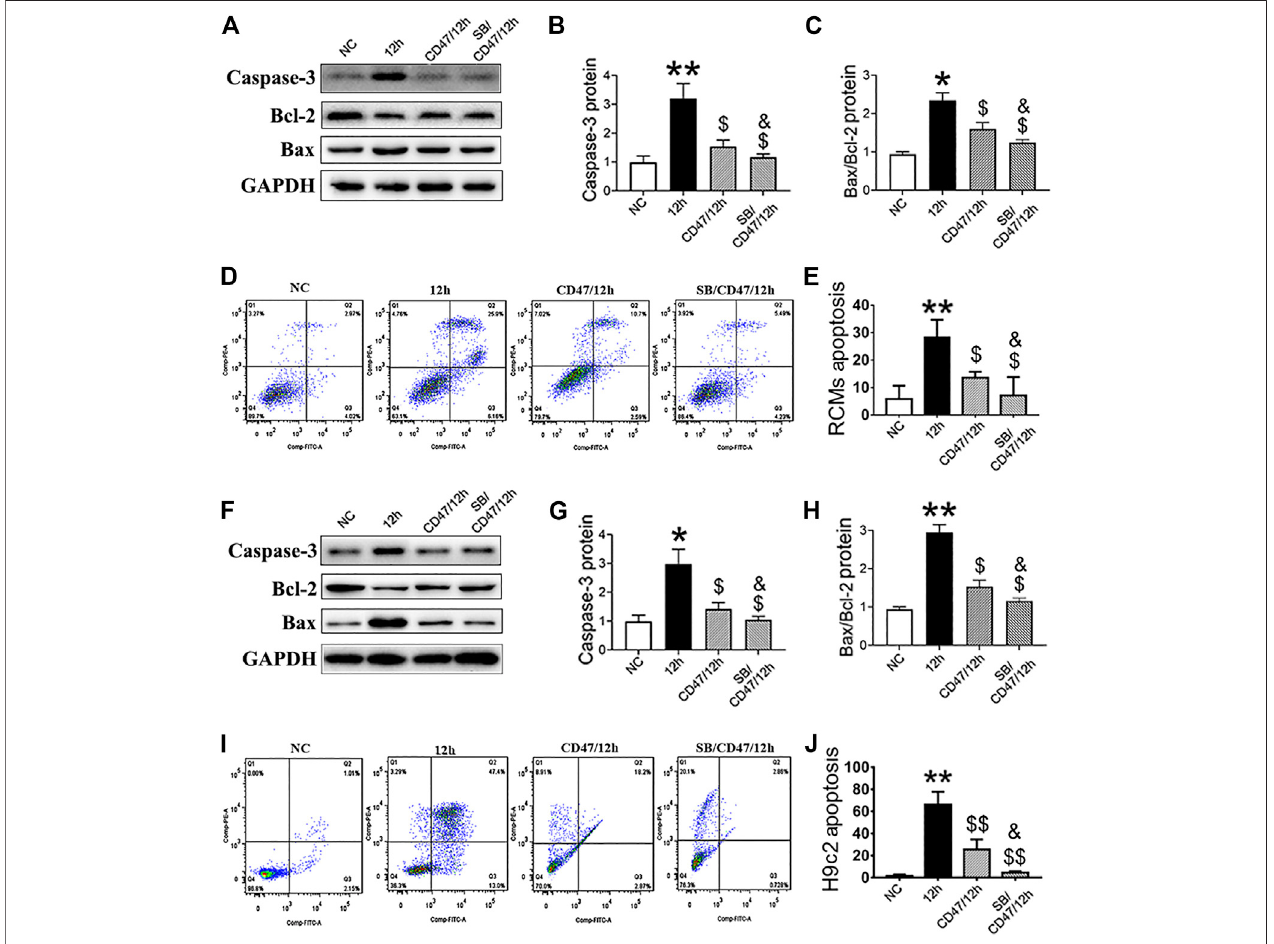
FIGURE 8 | Simultaneous targeting of GSK-3 β and CD47 can signi fi cantly reduce the apoptosis of hypoxic cardiomyocytes. Western blot analysis of caspase-3, Bcl-2, and Bax expressions in hypoxic RCMs (A – C) and H9c2 (F – H) cells with inhibited CD47 and GSK- β expression. Flow cytometry showed a decrease in the apoptosis ratein hypoxicRCMs (D, E) and H9c2 (I, J) cells with inhibited CD47 and GSK-3 β expression ( n (cid:2) 3/group). Dataare presented as themean ± SD. *p < 0.05, ** p < 0.01 vs. NC; $ p < 0.05, $$ p < 0.01 vs. 12 h; & p < 0.05 vs. CD47/12 h.